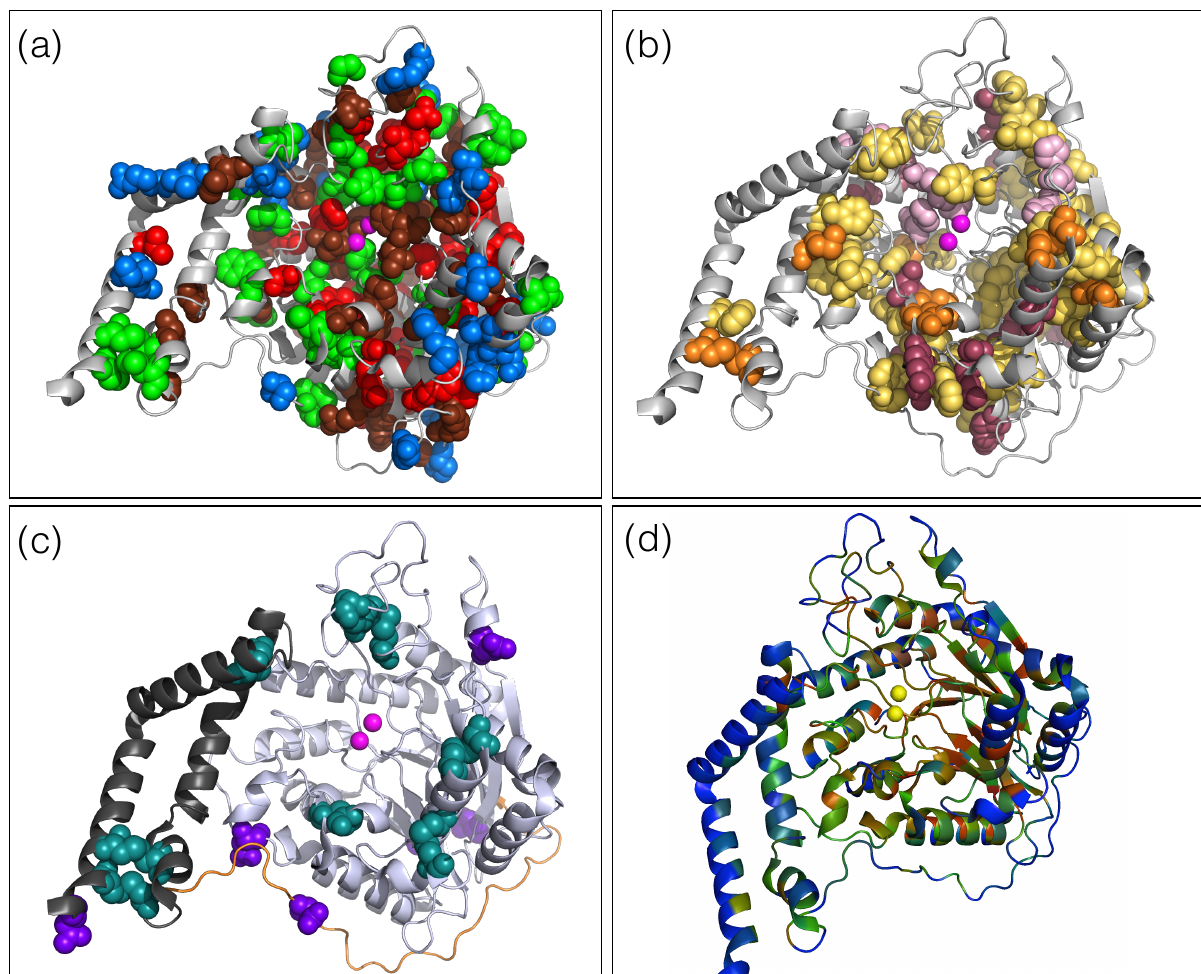
Figure 1. Three-dimensional X-ray structure of SMPD1 (PDB code 5i81). ( a ) NPDA, NPDB, NPD and neutral variant annotations are in red, green, brown and blue spheres, respectively, and Zn ions in magenta; ( b ) Aromatic residues involved in π - π , cation- π , amino- π , sulfur- π and His- π interactions are in yellow spheres, histidines involved in His- π interactions in light pink spheres, Arg, Lys, Gln and Asn involved in cation- π or amino- π interactions in raspberry red spheres, Met and Cys involved in sulfur- π interactions in orange spheres, Zn ions in magenta spheres; ( c ) Saposin domain is in black ribbon, Pro-rich linker domain in orange ribbon, catalytic domain in white-blue ribbon, disulfide bridges in teal spheres, glycosylation sites in purple spheres, Zn ions in magenta spheres; ( d ) SMPD1 is colored according to the 3-state SMPD1-ZooM scores averaged over all 19 possible variants per position, using the RGB color code with red, green and blue representing NPDA, NPDB and neutral predictions,